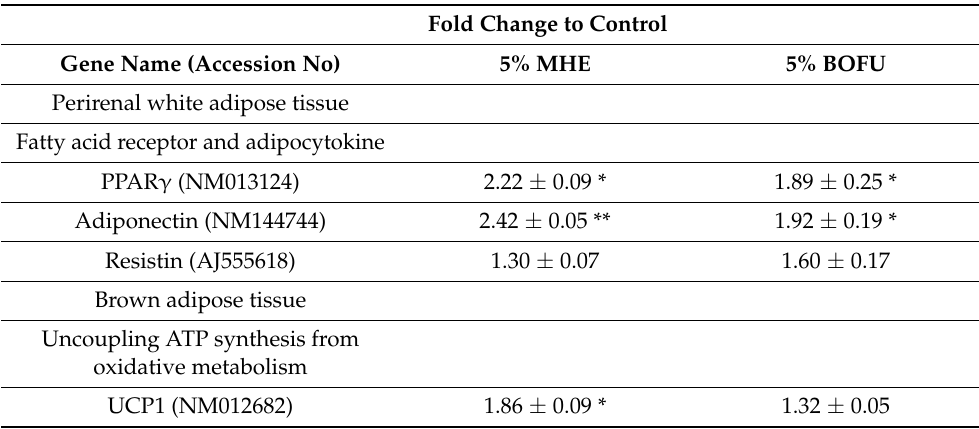
Table 9. Gene expression analysis in adipose tissue by real-time PCR following four weeks of MHE and BOFU exposure. Fold Change to Control Gene Name (Accession